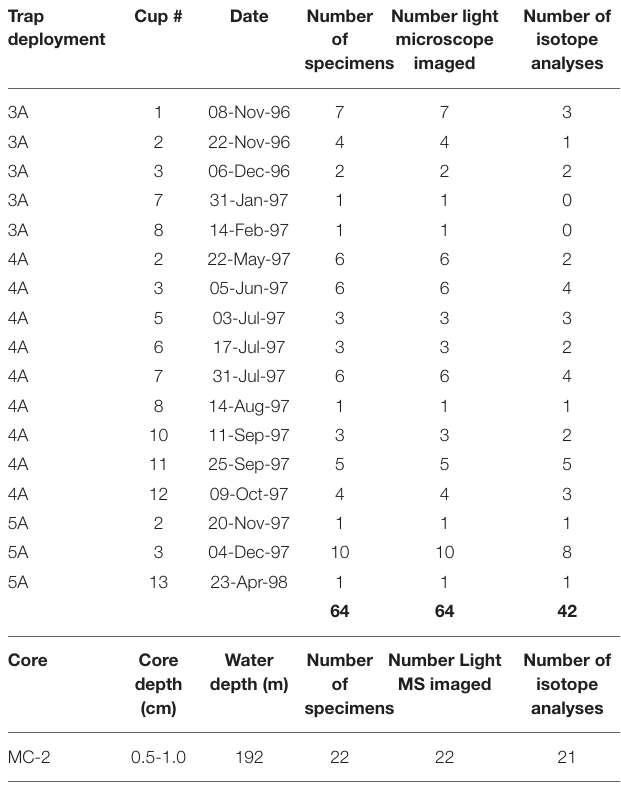
TABLE 1 | Sample information about the specimens from the sediment trap and the core top used in this